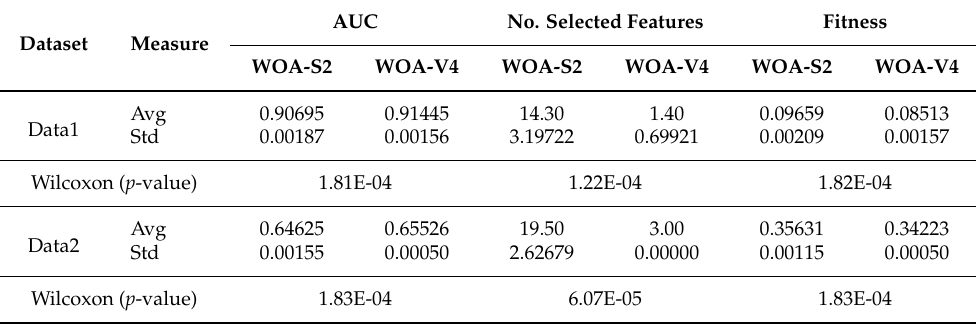
Table 12. Comparison of top variants WOA-S2 and WOA-V4 in terms of AUC, selected features, and fitness rates.